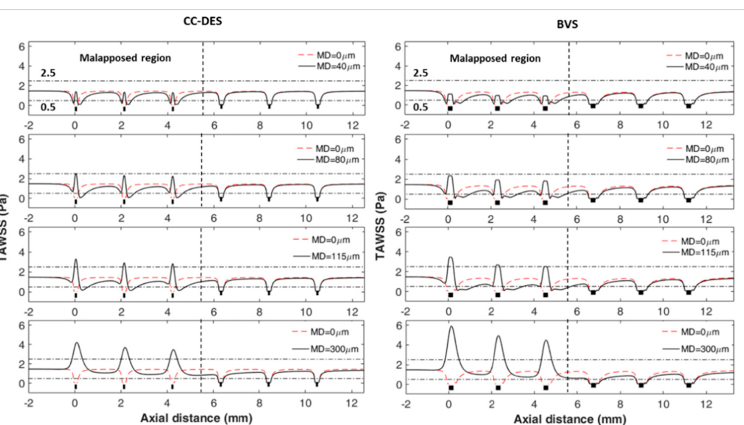
Figure 4. Time-averaged wall shear stress (TAWSS) distribution for the malapposition configuration. For simplicity reasons, only five representative configurations are displayed for each strut size (MD = 0, 40, 80, 115 and 300 µm). Strut locations are indicated with black rectangles. Notice that axial distance = 0 mm corresponds to the location of the first malapposed strut. Three TAWSS ranges can be defined: TAWSS < 0.5 Pa (Low TAWSS), 0.5 < TAWSS < 2.5 Pa (Normal TAWSS) and TAWSS > 2.5 Pa (High TAWSS).